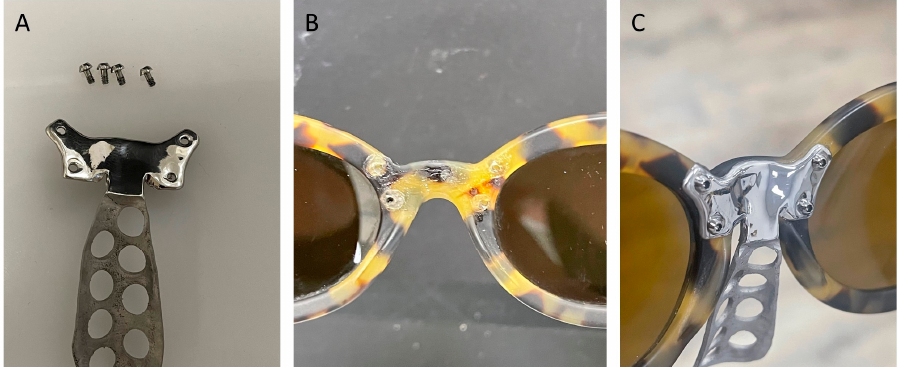
Figure 6. Final metal substructure, screws, and metal platform with four holes for connection to eyeglasses ( A ); female resin-splinted parts for screw fixation on the eyeglasses ( B ); substructure connected to the eyeglasses ( C ).